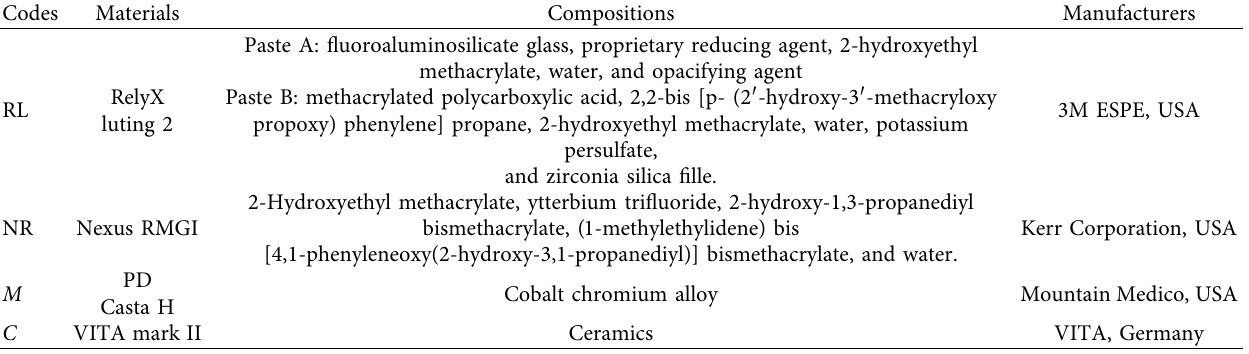
Table 1: RMGICs used in this